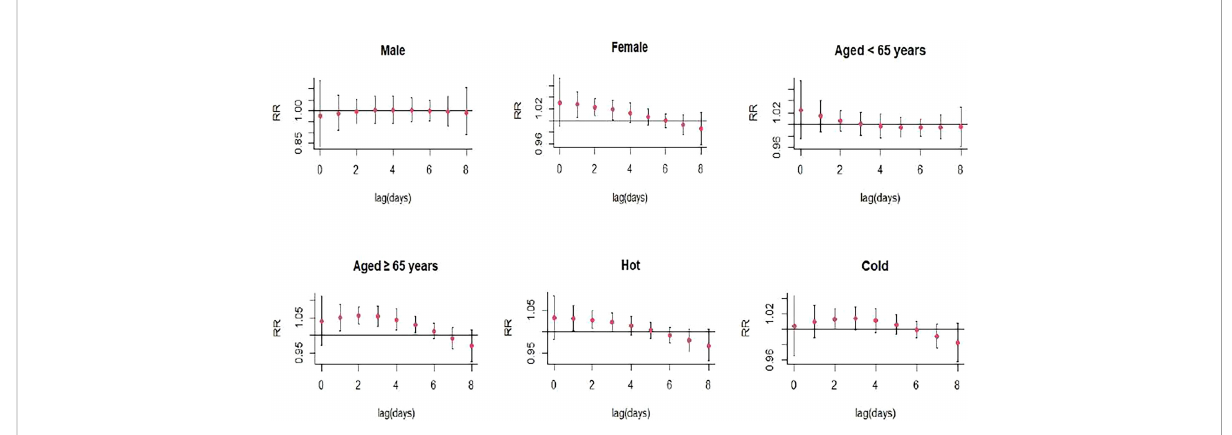
FIGURE 5 Lag-speci fi c relative risks (95% CI ) of SS hospitalizations per 10 unit increase in the daily concentrations of NO 2 in models strati fi ed by age, gender, and season.